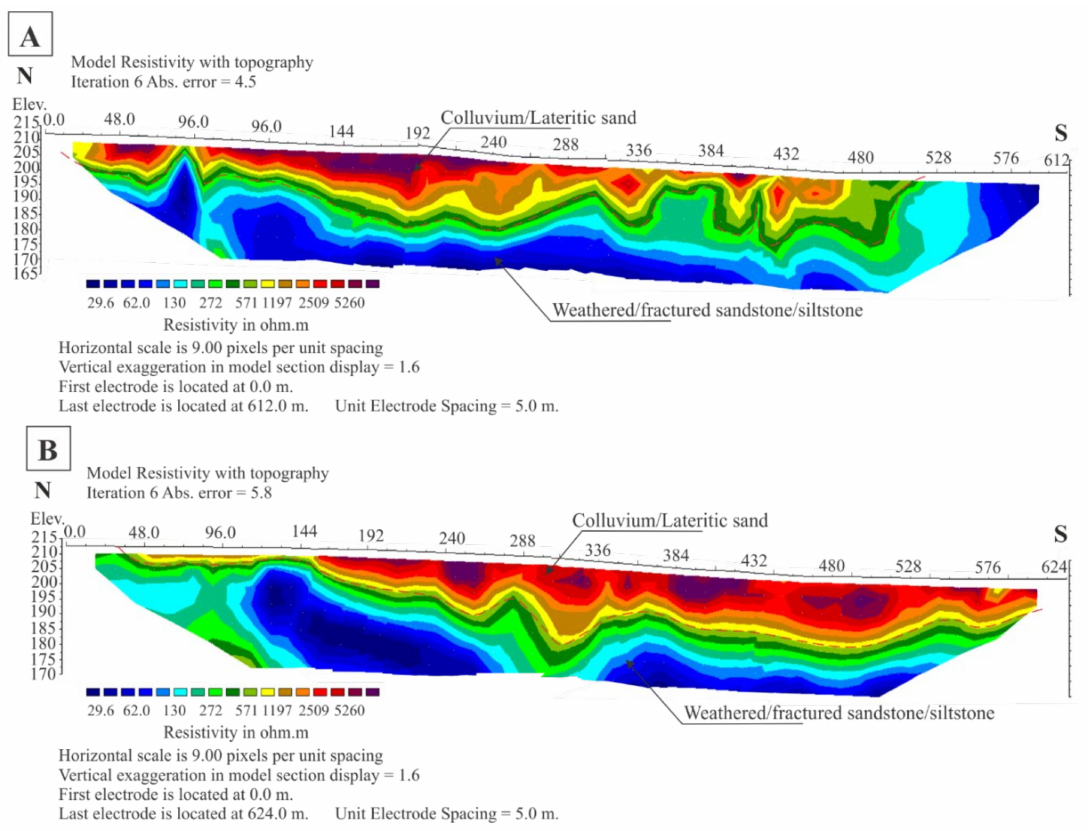
Figure 7. Inversion results of line KSL1 ( A ) and line KSL2 ( B ) show the high-resistivity layer of colluvium and lateritic soil on the top and below the low resistivity layer of clay, regolith, and fractured